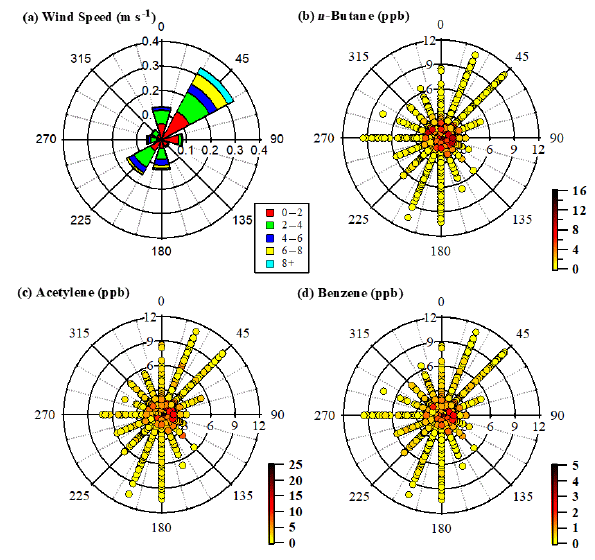
Figure 6. Wind rose (a) and concentration roses of (b) n- butane, (c) acetylene and (d) benzene for the period from 16 October 2015 to 15 February